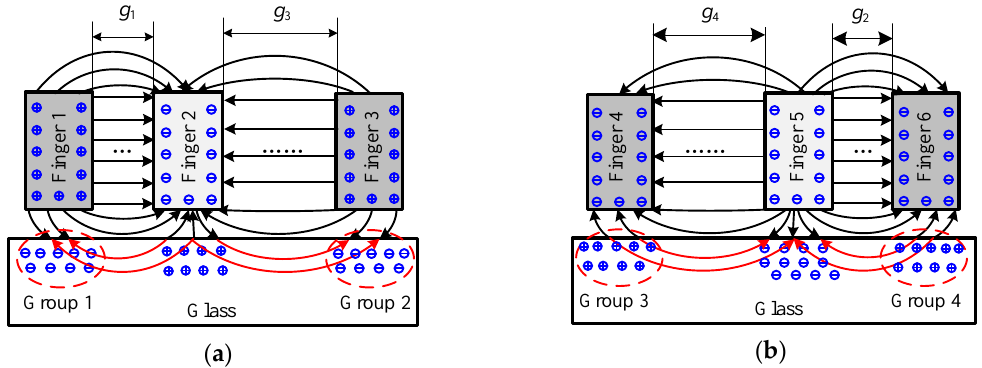
Figure 4. Glass polarization mechanism under an applied DC bias: ( a ) polarization of the top capacitor; and ( b ) polarization of bottom capacitor.